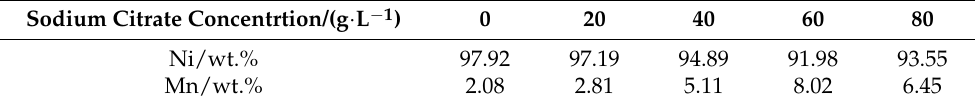
Table 2. Effect of sodium citrate concentration on the composition of coatings.